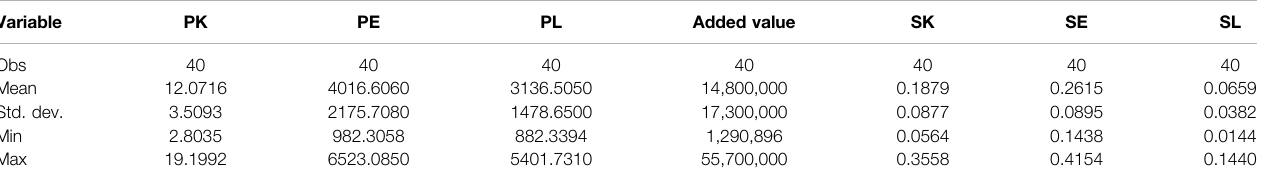
TABLE 1 | The value of every variable.